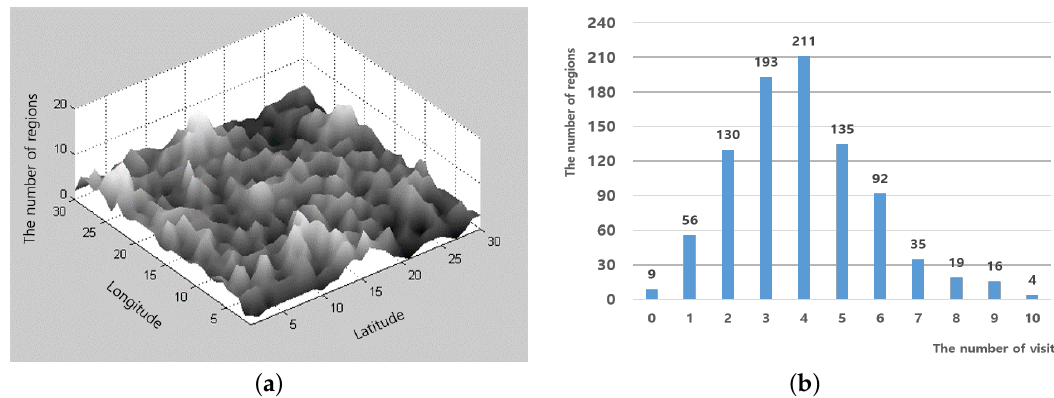
Figure 9. The results of RDPZ: ( a ) the coverage distribution; and ( b ) the number of the visits in each unit region.